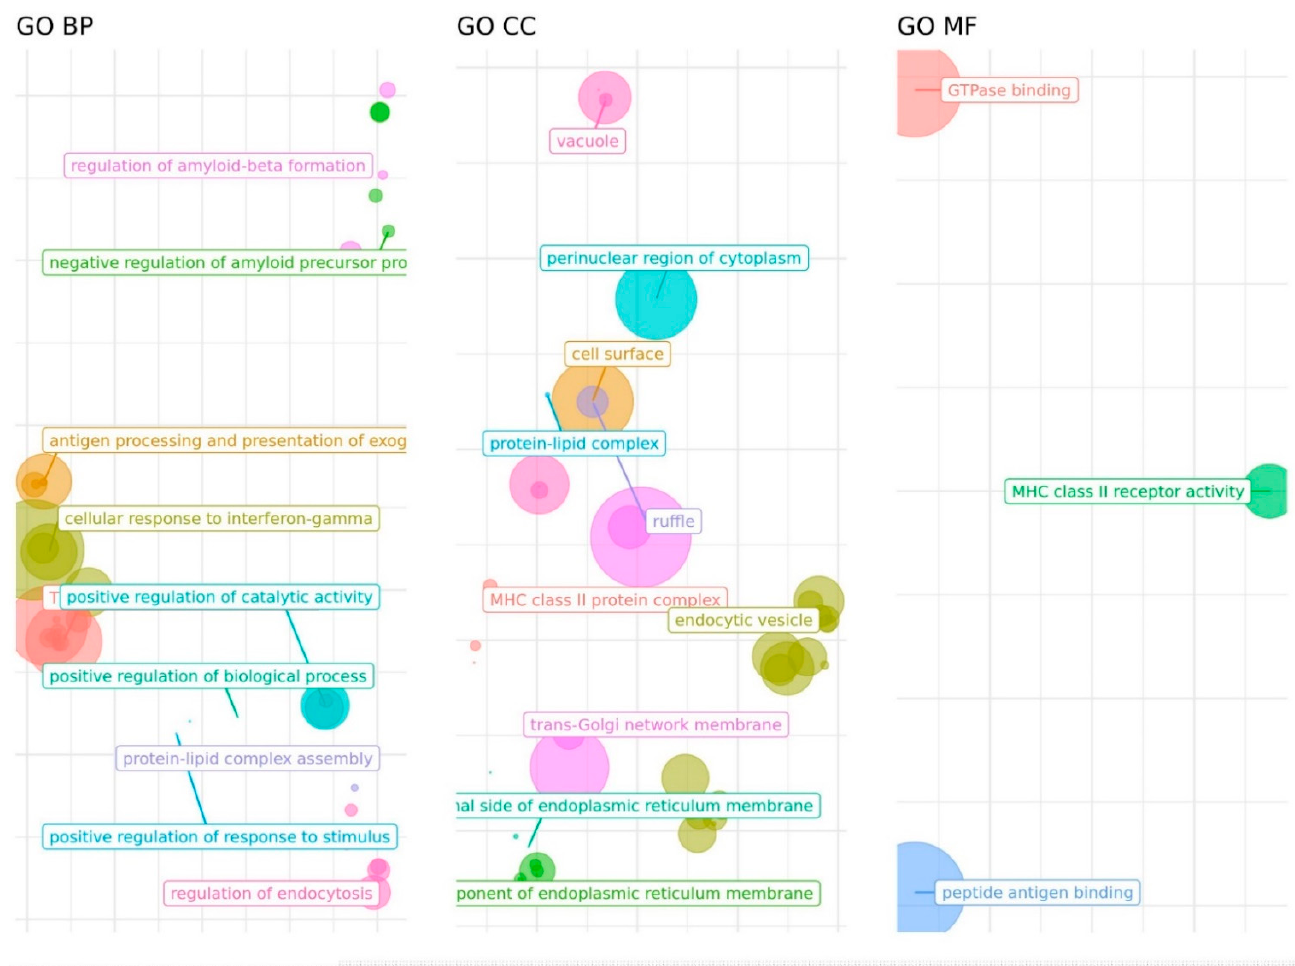
Figure 1. Gene Ontology (GO) categories over-represented among genes regulated by AD eQTLs. BP: Biological Process; CC: Cellular Component, MF: Molecular Function. Distances between points represent the similarity between terms. Axes are the first 2 components of applying a Principal Component Analysis (PCA) to the (di)similarity matrix. Size of the point represents the provided scores or, in its absence, the number of genes the GO term contains.